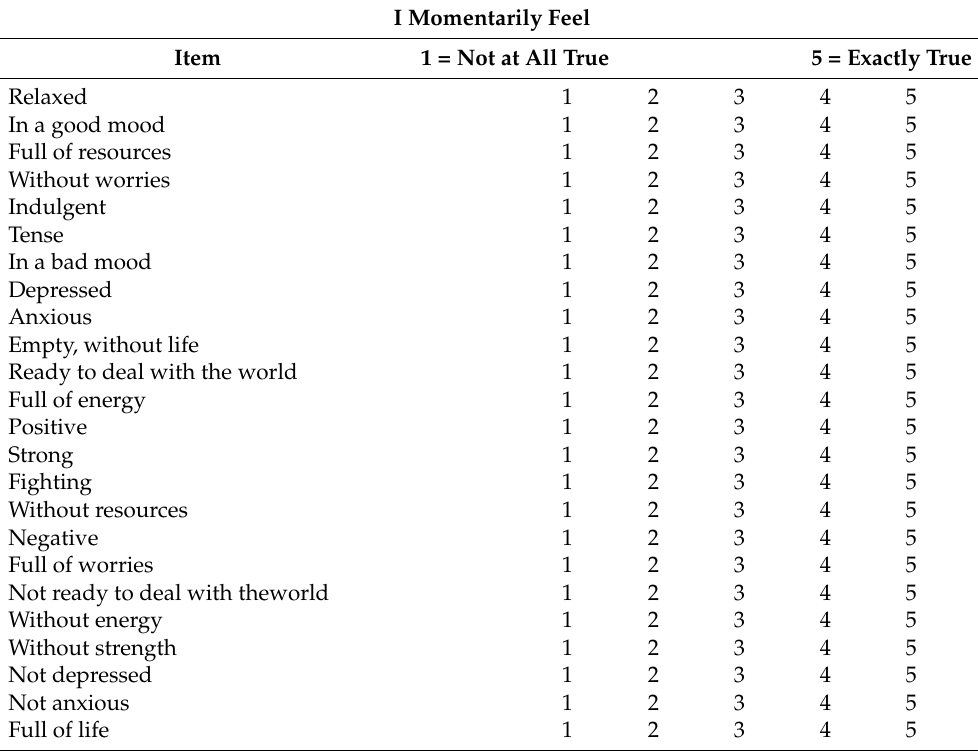
Table A1. Heidelberg State Inventory ( HSI ; English Translation;